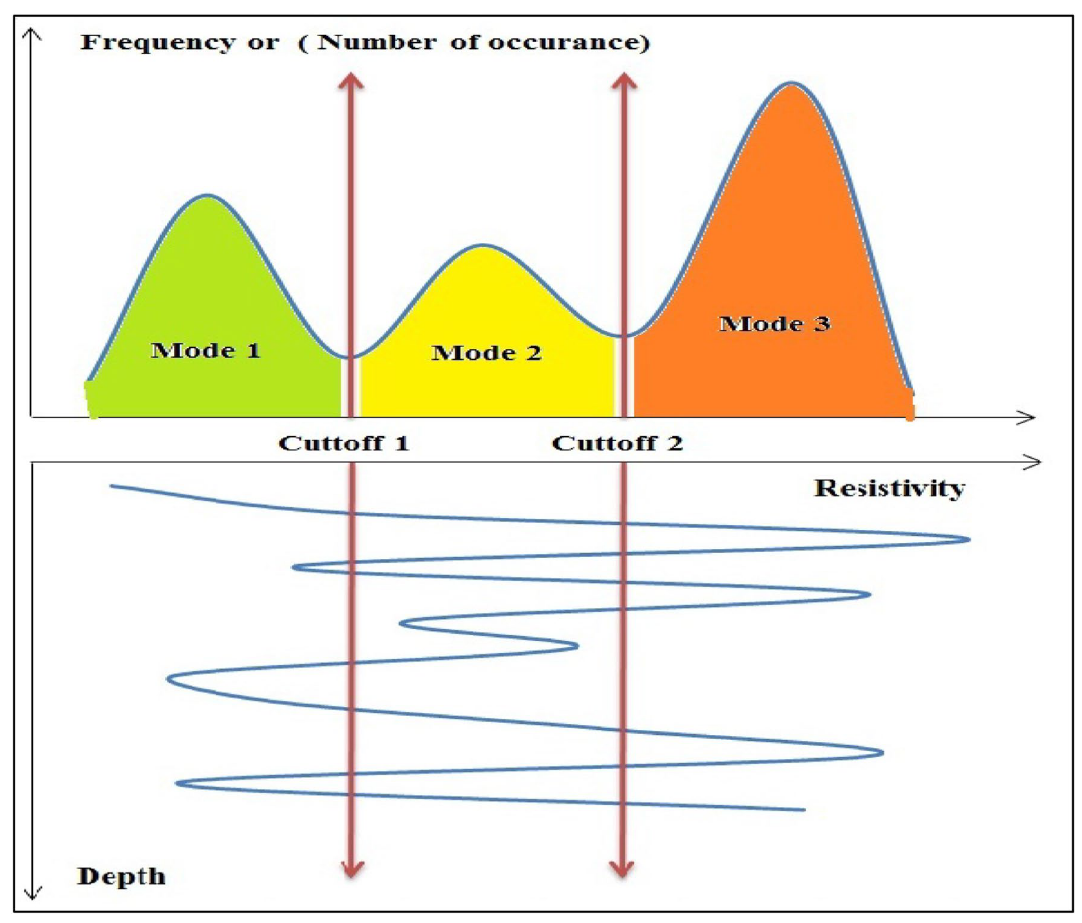
Fig. 5 Plot of the image log